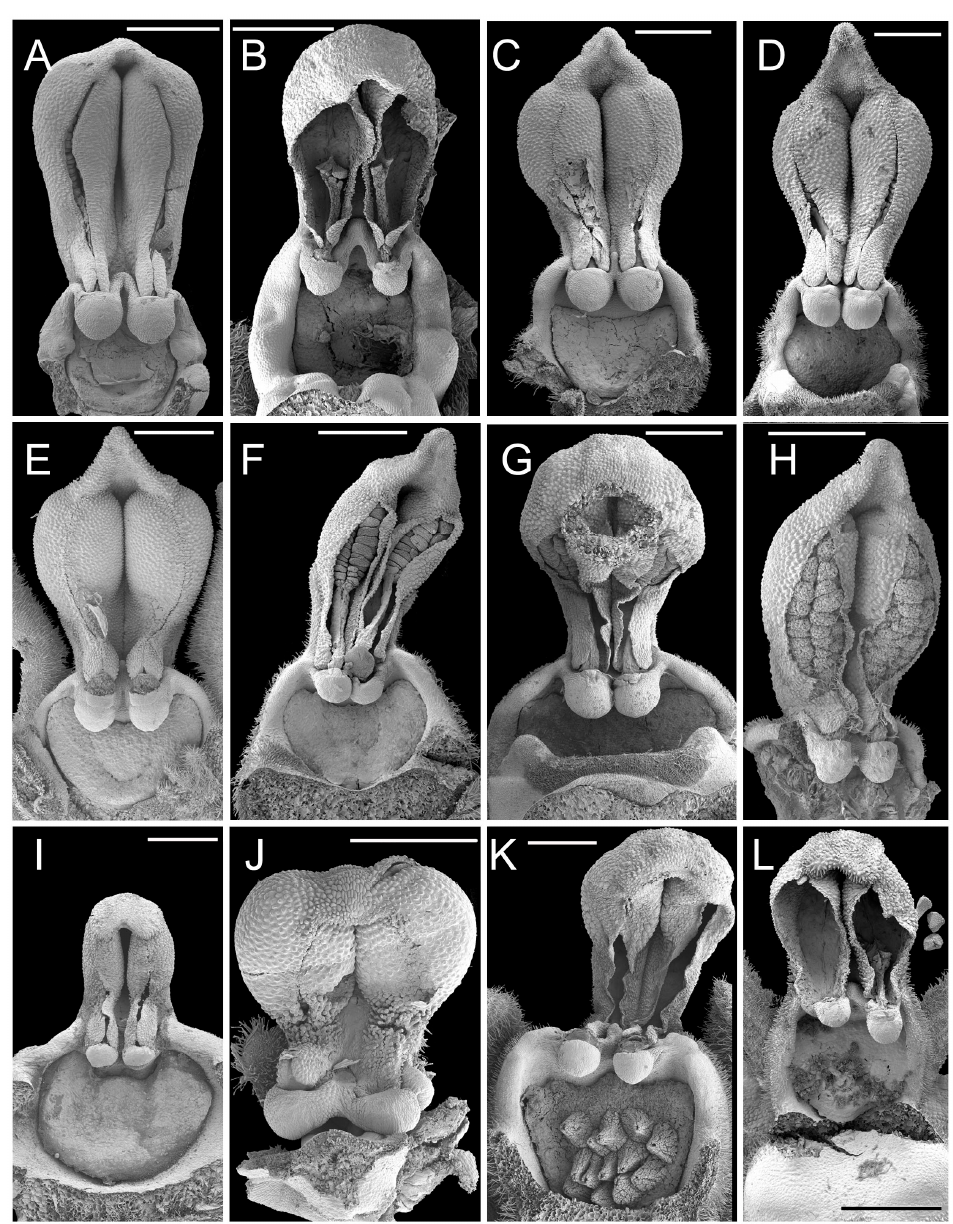
Figure 4. Scanning electron micrographs of gynostemia of 12 Ophrys microspecies, collectively representing seven of the nine macrospecies. ( A ) O. vernixia : mesospecies Speculum , macrospecies Speculum. ( B ) O. regis-ferdinandii : mesospecies Speculum , macrospecies Speculum. ( C ) O. ferrum-equinum : mesospecies Mammosa , macrospecies Sphegodes. ( D ) O. heldreichii : mesospecies Heldreichii , macrospecies Fuciflora. ( E ) O. mammosa : mesospecies Mammosa , macrospecies Sphegodes. ( F ) O. cretensis : mesospecies Mammosa , macrospecies Sphegodes. ( G ) O. lacaena : mesospecies ‘Bornmuelleri’ , macrospecies Fuciflora. ( H ) O. sphegodes : mesospecies Sphegodes , macrospecies Sphegodes. ( I ) O. phryganae : mesospecies Lutea , macrospecies Fusca. ( J ) O. bombyliflora : mesospecies Bombyliflora , macrospecies Bombyliflora. ( K ) O. cf. leochroma : mesospecies Tenthredinifera , macrospecies Tenthredinifera. ( L ) O. insectifera : mesospecies Insectifera , Macrospecies Insectifera. Scale in all images =1 mm. Images: Paula